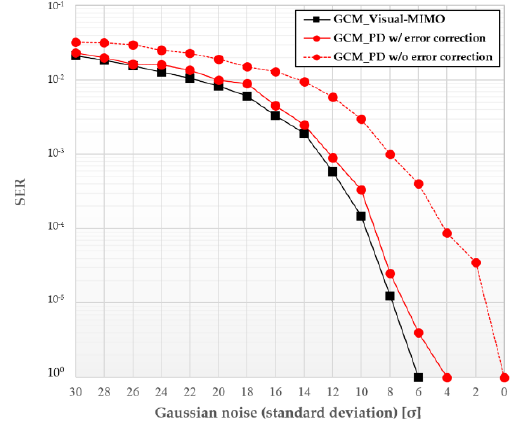
Figure 9. SER performance comparison between visual-MIMO and LED-PD communication under color variation.